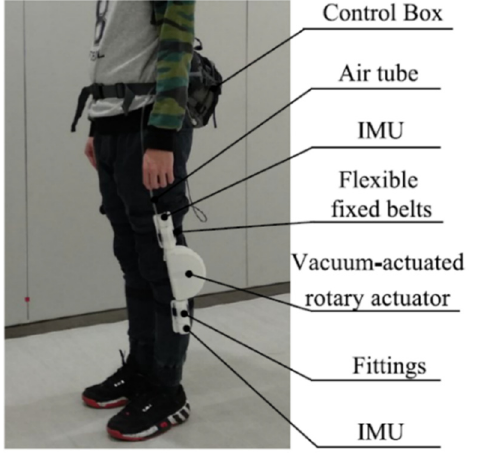
Figure 9. Soft assistive lower limb exoskeleton, ( a ) front and ( b ) rear view [84] (Open access).